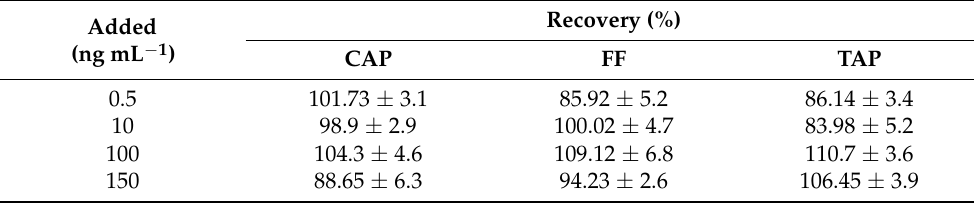
Table 2. The standard recovery data for the determination of amphenicols in water samples. Three tests were repeated for each